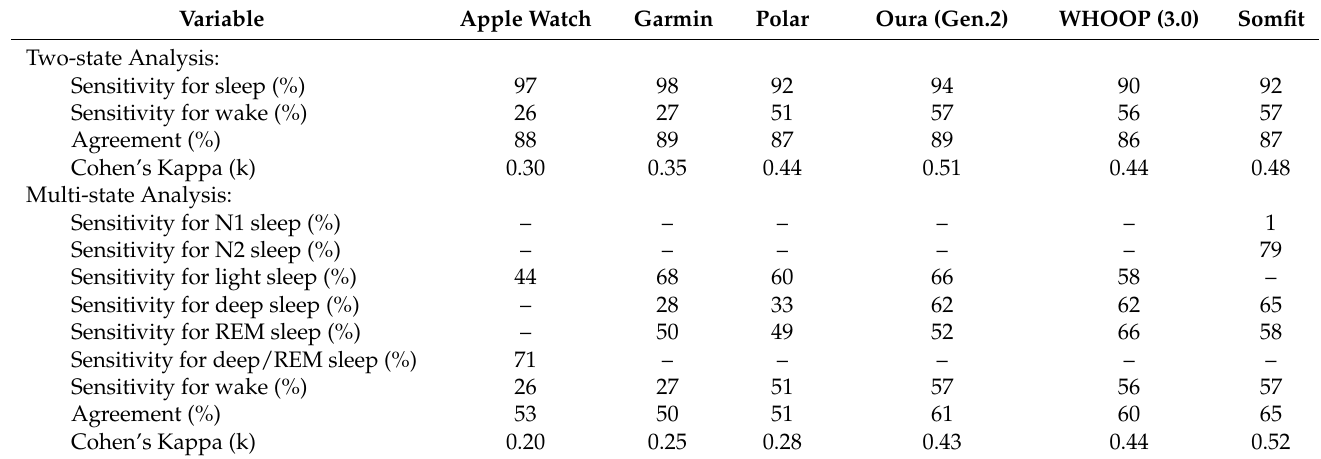
Table 3. Epoch-by-epoch statistics between PSG and each device.